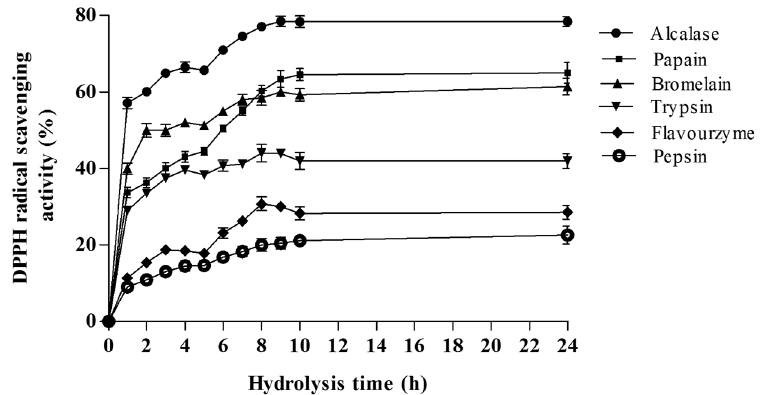
Figure 3. Effect of hydrolysis time on the DPPH radical scavenging activities (%) of different A. lecanora hydrolysates generated from enzymatic digestion for 24 h. Sample concentration for this assay was 1.0 mg/mL. Results represent the means ± SD of three replications.